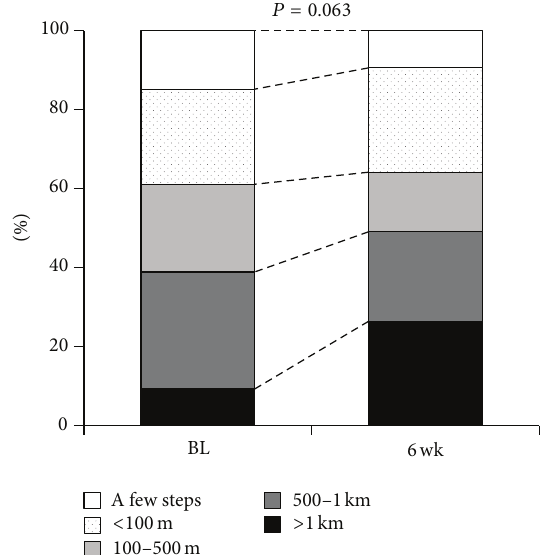
Figure 5: Changes in the intermittent claudication (IMC) distance. The IMC distance shows a tendency to increase after the 6-week administration of PGB, with apparent